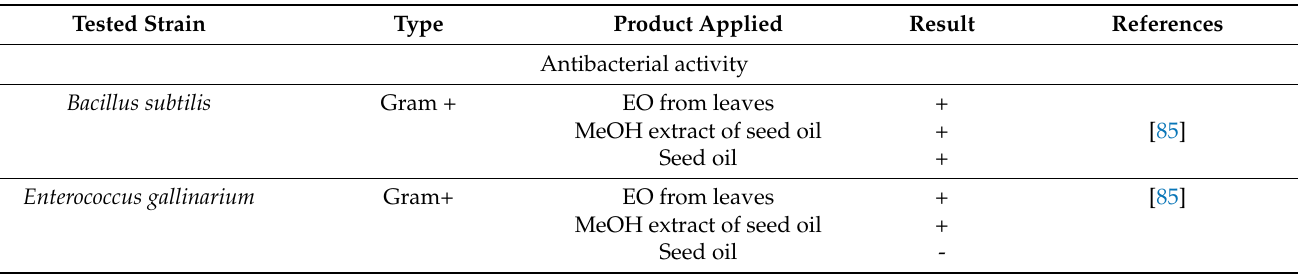
Table 4. Antimicrobial activity of L. nobilis on some strains